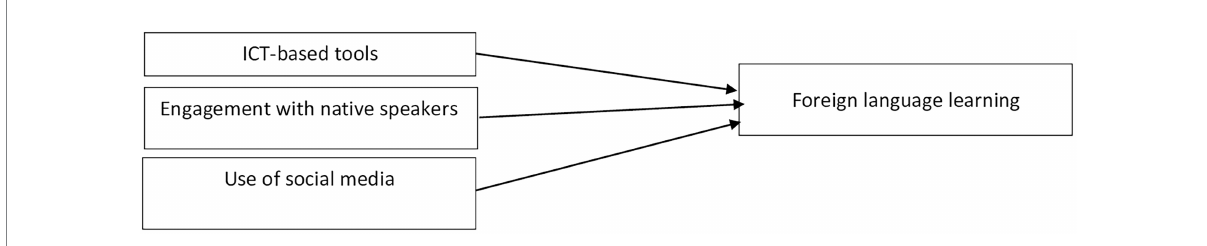
FIGURE 2 The conceptual framework of this